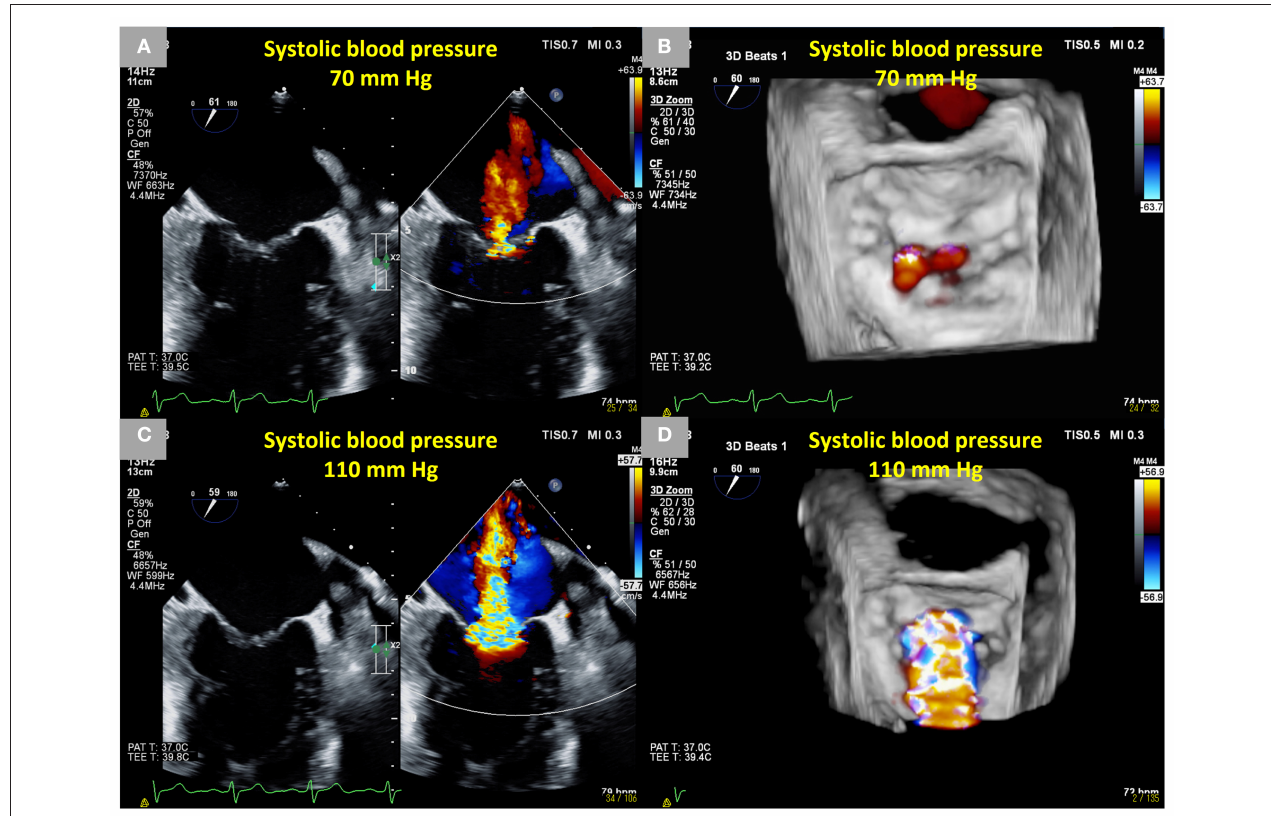
FIGURE 1 | Dynamic changes in SMR during transesophageal echocardiography in a 66-year-old male patient who had an anterior old myocardial infarction and heart failure with reduced ejection fraction. Mild SMR (EROA 0.10 cm 2 ) under sedation using midazolam under a systolic blood pressure of approximately 70mm Hg. (A) Two-dimensional B-mode and color Doppler images from the intercommissural view and (B) a three-dimensional color Doppler image from the en-face view. Dynamic severe SMR (EROA 0.51 cm 2 ) under an elevated systolic blood pressure of approximately 110mm Hg using norepinephrine. (C) Two-dimensional B-mode and color Doppler images from the intercommissural view and (D) a three-dimensional color Doppler image from the en-face view. SMR, secondary mitral regurgitation; EROA, effective regurgitant orifice